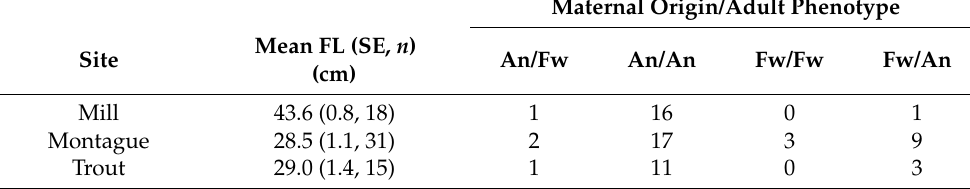
Table 1. Summary statistics and phenotypes of 64 brook trout sampled for otolith microchemistry where individual lengths were measured in fork length (FL, cm). Phenotypes are designated from Sr:Ca ratios as anadromous (An) or freshwater (Fw) for maternal life history (<200 µ m) and migratory life history (>500 µ